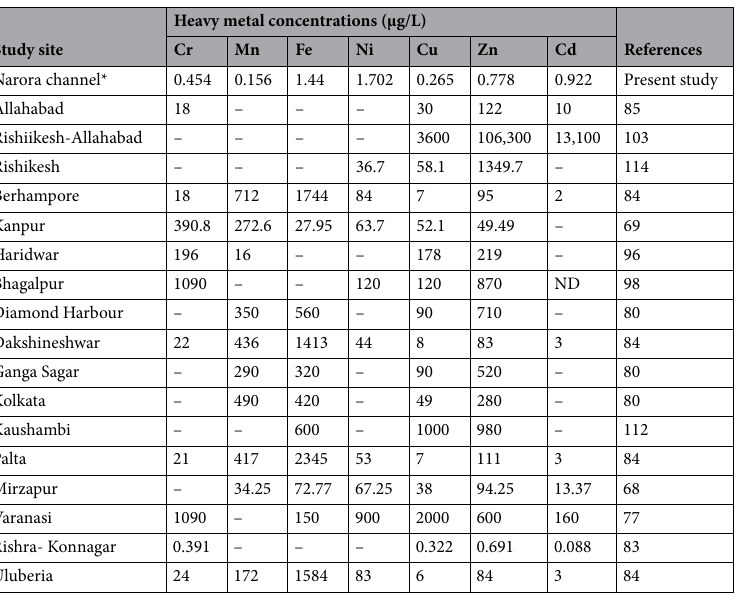
Table 8. Concentrations of different heavy metals in the different stretches and tributary of river Ganga. *In the present study the values are in mg/L. ND not